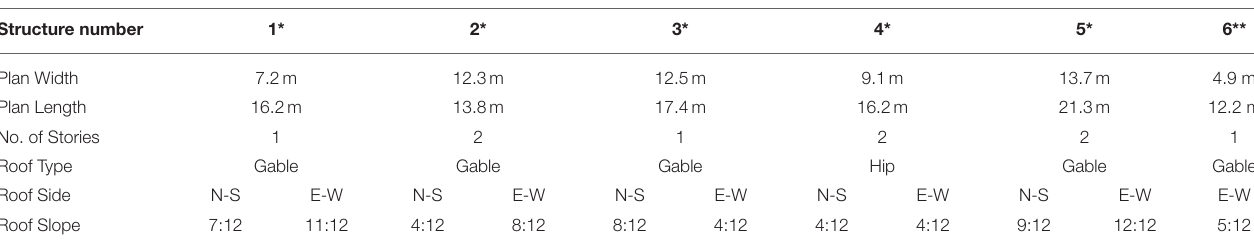
TABLE 1 | Description of residential